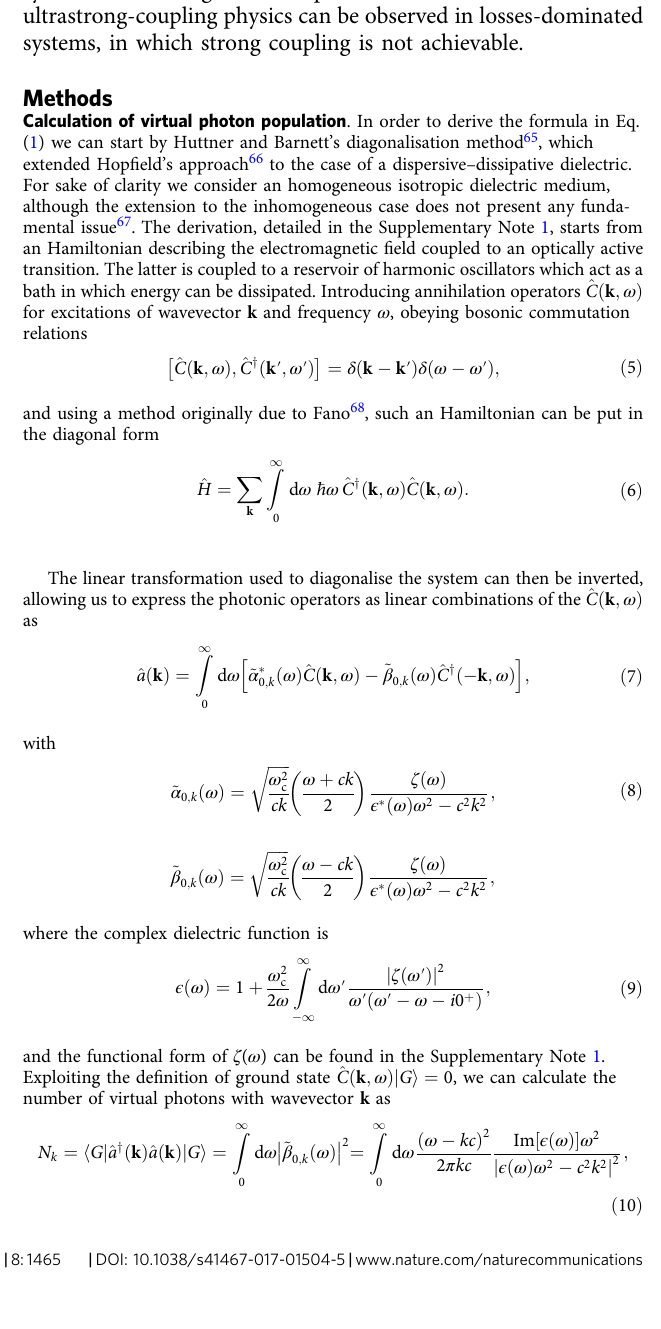
γ = 0 (thin blue line), 0.5 ω L 0 (solid